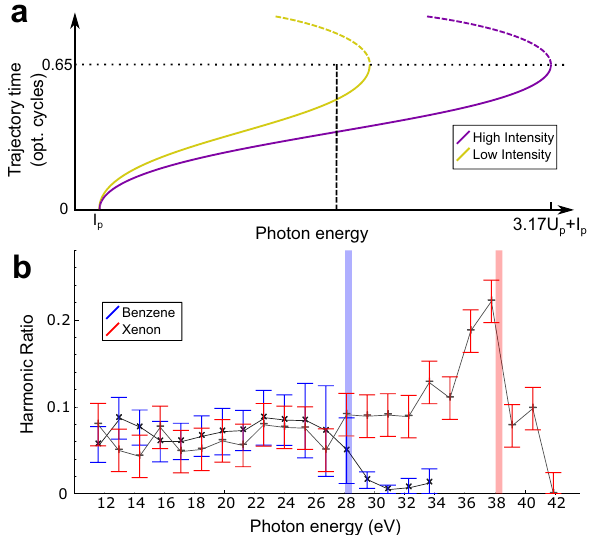
Figure 1. ( a ) Mapping of emitted photon energy to trajectory time for two different laser intensities, purple (higher) and yellow (lower). The “short” photoelectron trajectories recombining within 0.65 of the laser-cycle duration (solid lines) will contribute to the on-axis harmonic emission. Trajectories recombining at later times (dashed lines) do not contribute. The vertical dashed line shows two different evolution times being sampled at a single photon energy. ( b ) Low-to-high laser intensity ratios of harmonic yields in benzene (blue, 15 TW/ cm 2 and 35 TW/ cm 2 ) and in xenon (red, 25 TW/ cm 2 and 40 TW/ cm 2 ). The vertical shaded regions indicate the classical cutoffs corresponding to the lower intensities. Error bars reflect plus and minus one standard deviation of the ratio across six repetitions in benzene, restricted to positive